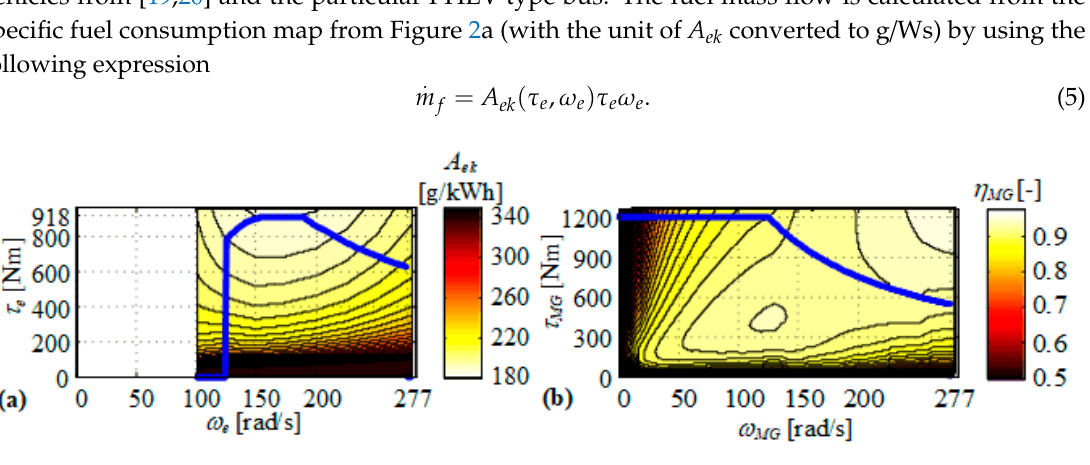
Figure 2. ( a ) Engine specific fuel consumption map and ( b ) M/G machine efficiency map, including corresponding maximum torque lines (blue lines).